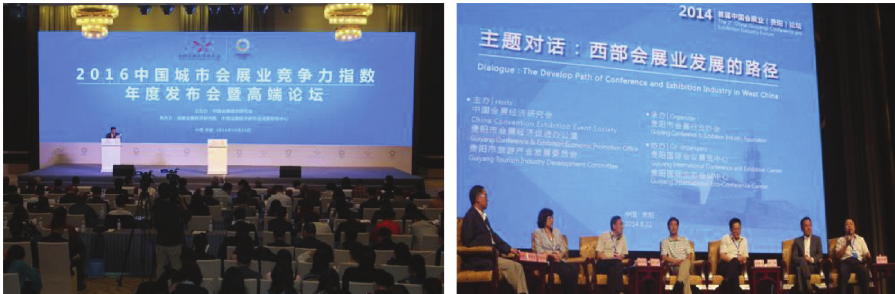
Figure 2: Exhibition industry has been paid more and more attention by domestic